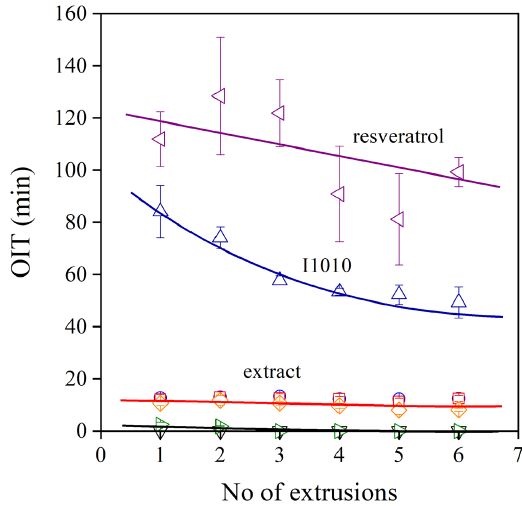
Figure 8. Dependence of the residual stability of HDPE stabilized with different phenolic compounds. Symbols are the same as in Figure 6.